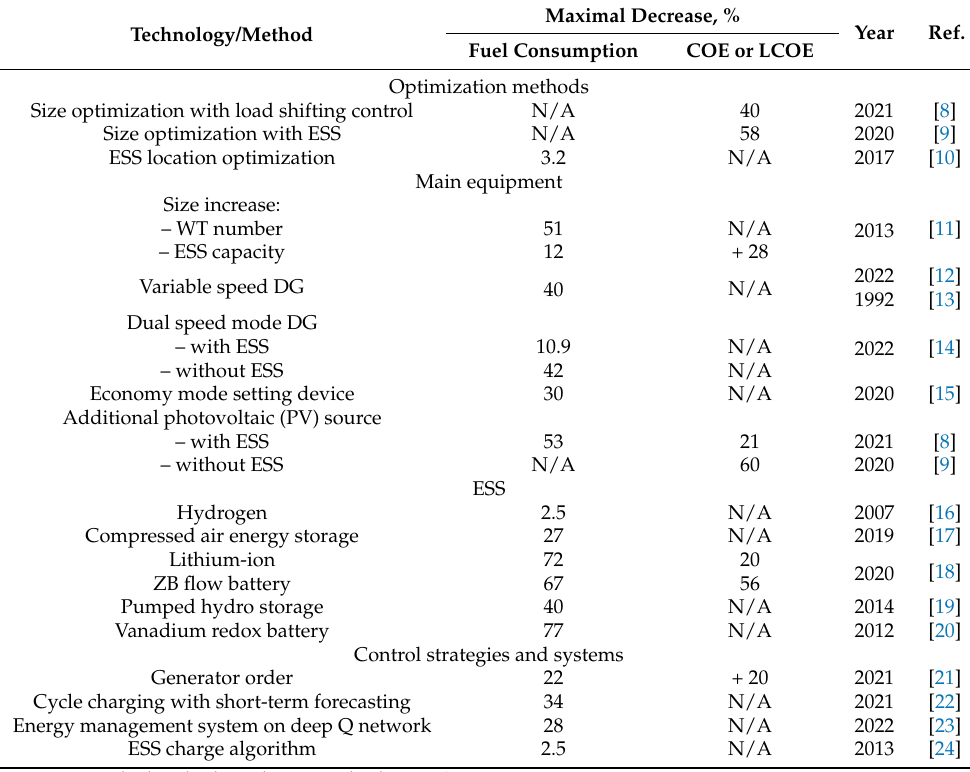
Table 1. Overview of the efficiency of WDHS diesel fuel saving